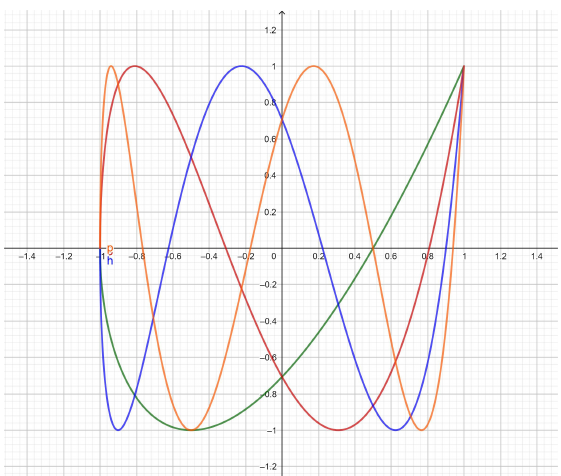
Figure 1. Pseudo T k + 1/2 , k = 1,2,3,4,5. 1, green; 2, red; 3, blue; 4,